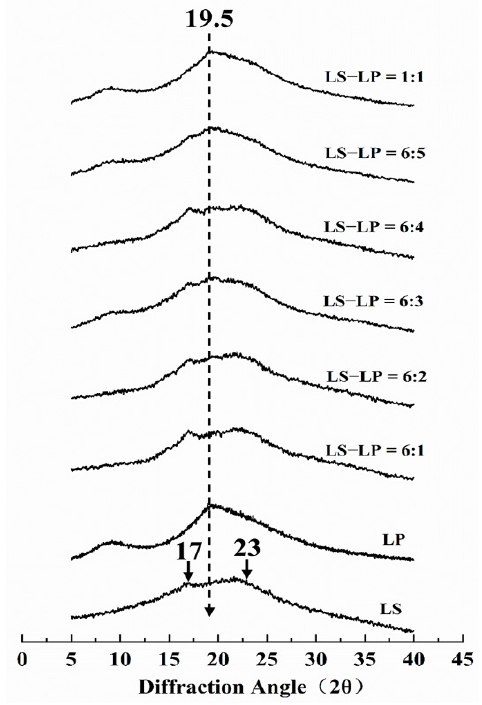
Figure 5. The X-ray diffraction pattern of lotus seed starch–protein mixture. Note: The figure displayed that lotus seed starch–protein mixture (LS-LP). LS indicates lotus seed starch. LP indicates lotus seed protein. LS-LP = 6:1–5 or 1:1 indicates lotus seed starch–protein with different ratios.